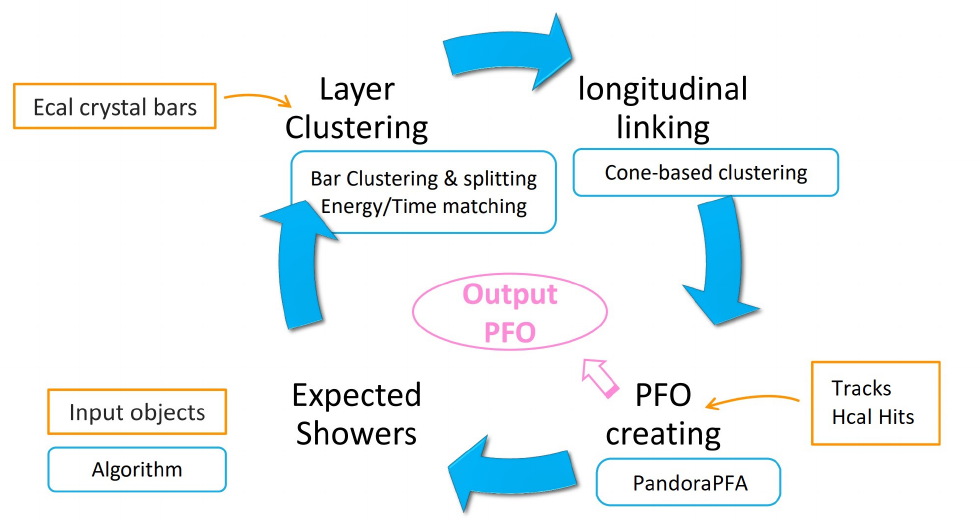
Figure 5. Dedicated reconstruction flow for the crossed long crystal bar